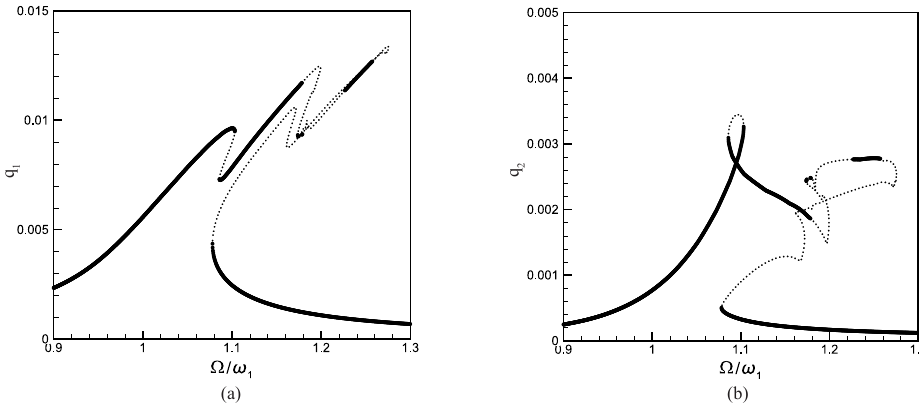
Fig. 3. The frequency response curve of the system possessing a three-to-one internal resonance between the first two modes, i.e. ω 2 ≈ 3 ω 1 . Bold and dotted lines represent the stable and unstable solutions, respectively.